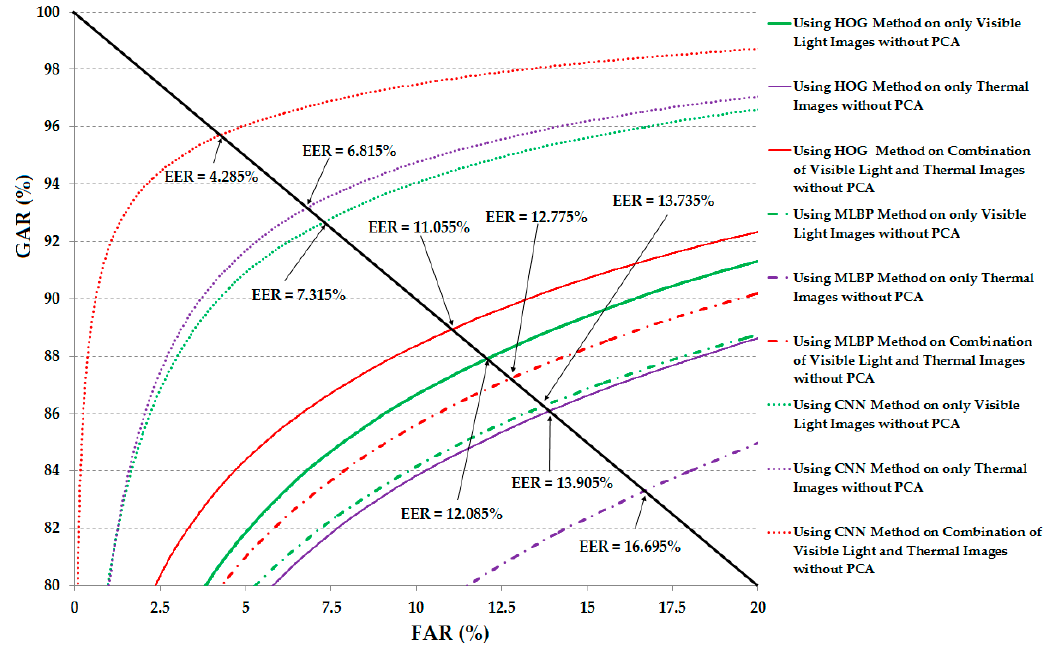
Figure 10. Receiver operating curves (ROC) of the verification systems (system that uses only visible light, only thermal, and a combination of visible light and thermal images for verification) using Euclidean distance without applying principal component analysis (PCA).